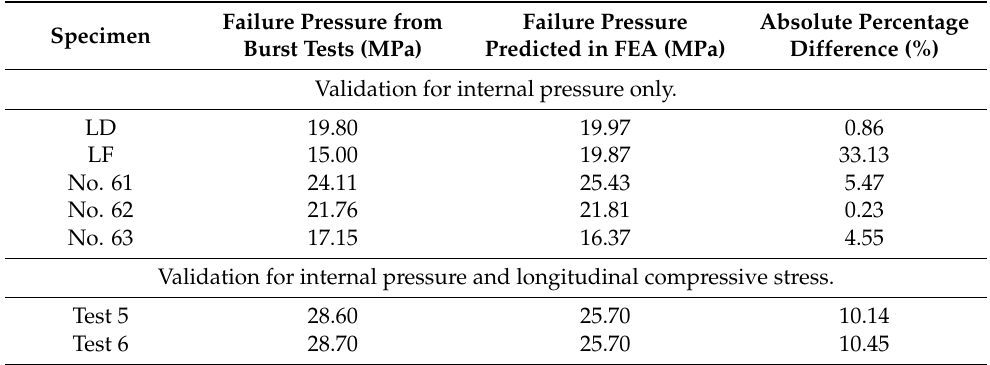
Table 10. Failure pressure from burst tests compared with failure pressure predicted by new assess- ment equations.